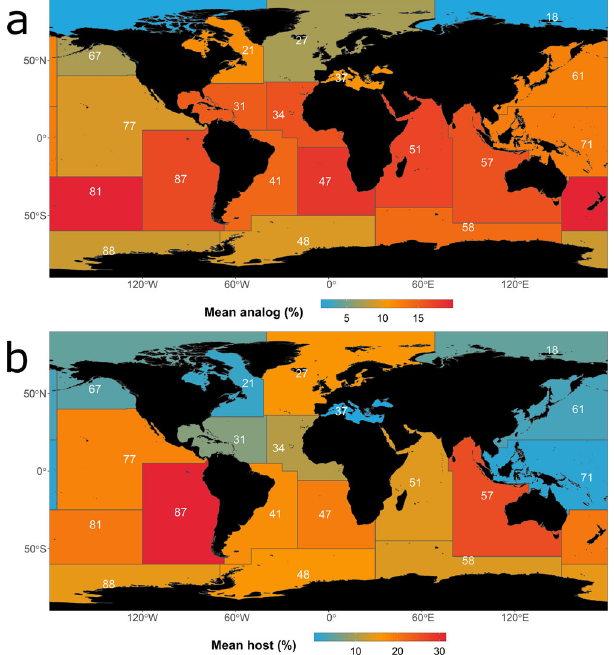
Fig. 4 Connectivity status on Major Fishing Areas (MFAs) from Food and Agriculture Organization (FAO). Each MFA is presented by its unique identi fi cation number (label). Connectivity metrics represent the mean percentage of pixels that will have an analog in the other MFAs in the future a and the mean percentage of pixels that will host analogs from other MFAs in the future b